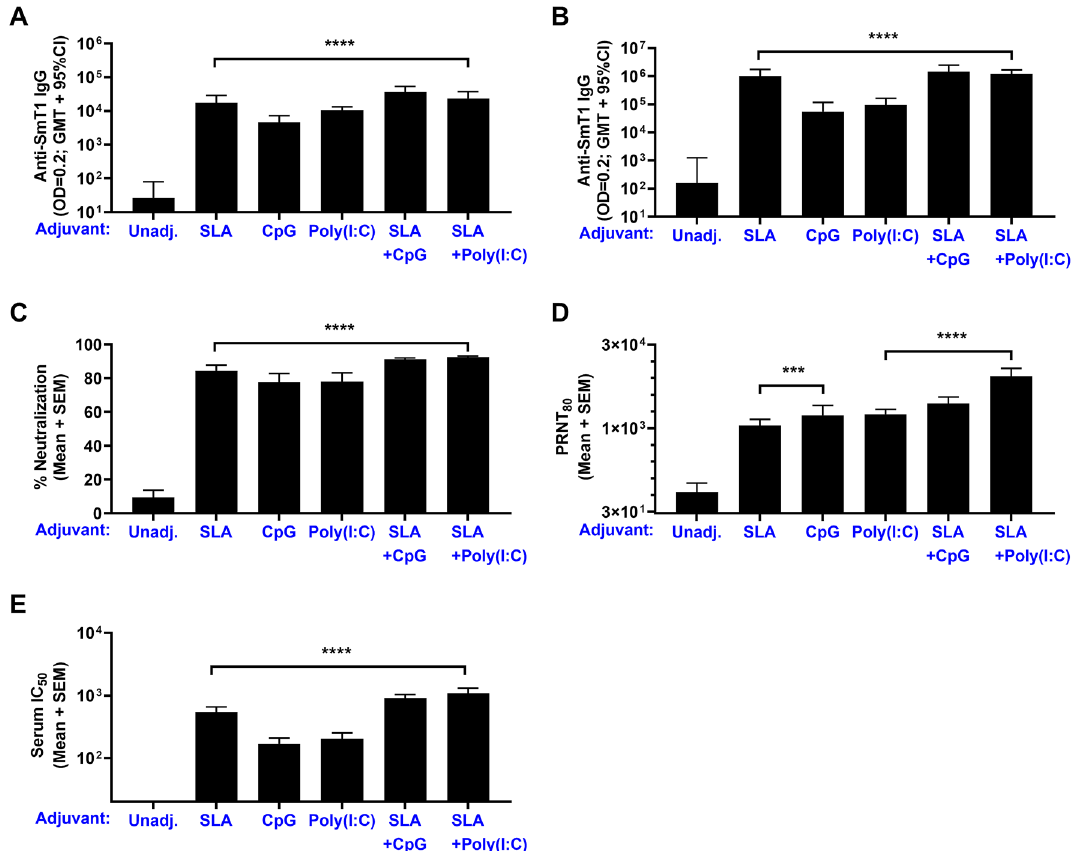
Figure 4. Humoral immune response with SmT1-based vaccine formulations adjuvanted with SLA, CpG and Poly(I:C) alone or in combination. C57BL/6 mice (n = 10/group) were immunized i.m. with 1 µg of SmT1 alone or with SLA, CpG and Poly(I:C) alone or in combination on Days 0 and 21. Serum was collected on Days 20 ( A ) and 28 ( B ) and analyzed by ELISA to determine the antibody titers. Grouped data is presented as geometric mean + 95% confidence interval. Serum from Day 28 was also analyzed at a final serum dilution of 1:75 by cell-based surrogate neutralization assay ( C ). Serial dilutions of serum were also tested in a SARS-CoV-2 plaque reduction neutralization titer assay ( D ) or plate-based spike-ACE2 neutralization assay ( E ). Grouped data is presented as mean + standard error of mean. Statistical significance of differences between the adjuvanted groups vs. the unadjuvanted control group is shown: ***p < 0.001 and ****p < 0.0001 by one-way ANOVA followed by Tukey’s multiple comparisons